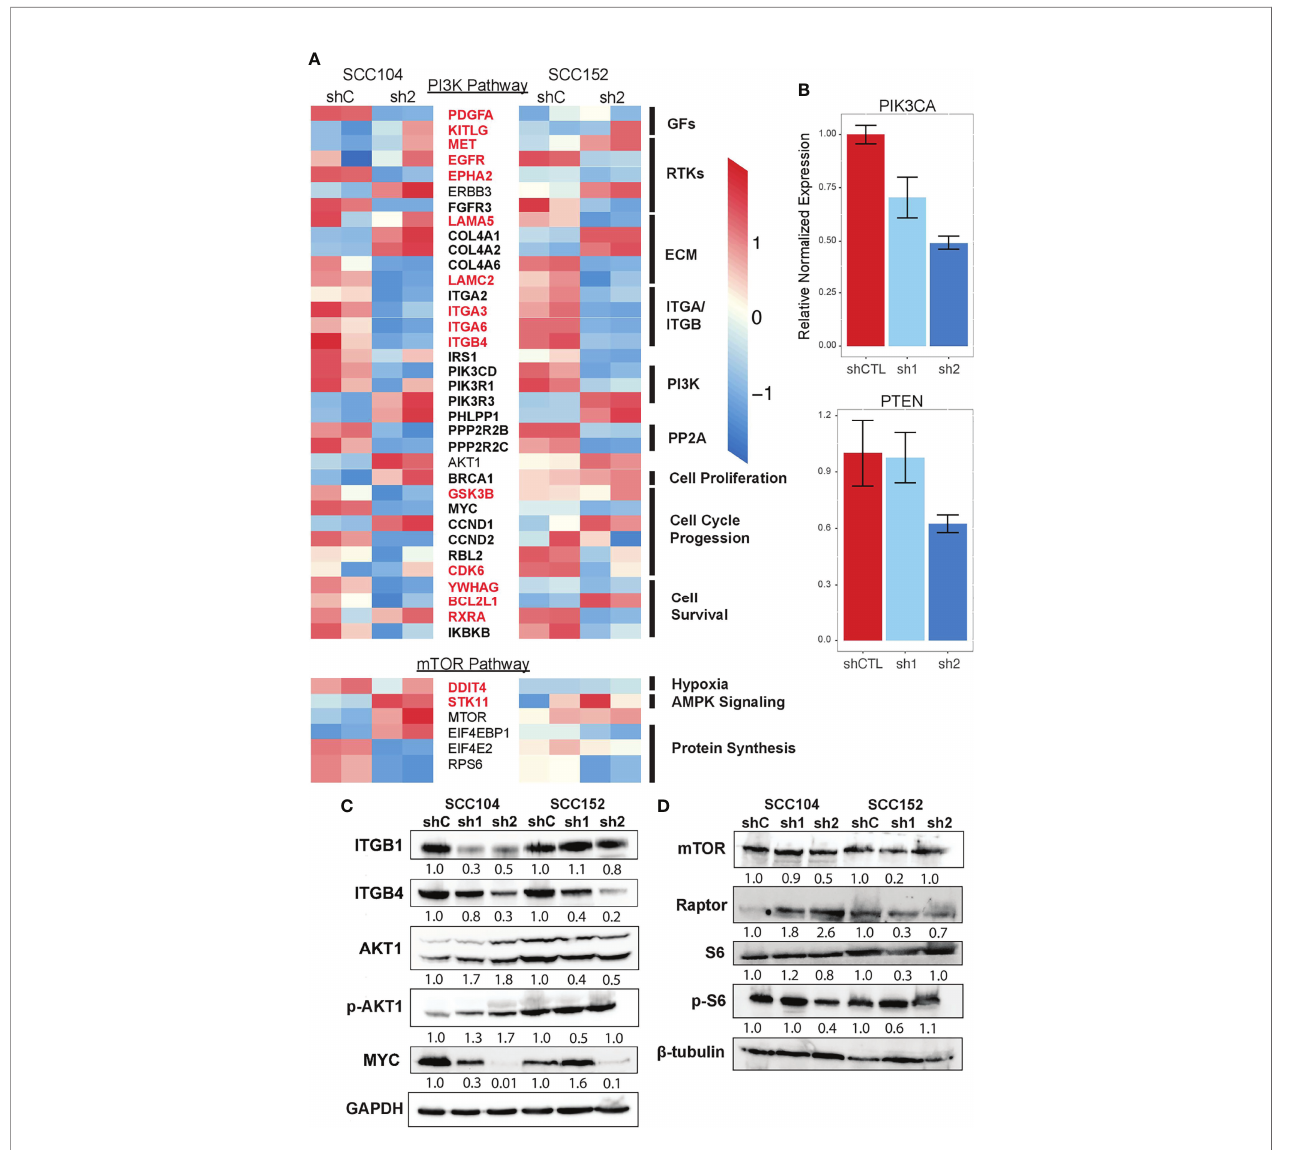
FIGURE 7 | PI3K and mTOR signaling is downregulated upon loss of p63 expression. (A) Heatmap of select DEGs shared between SCC104 and SCC152 cells after p63 knockdown that are associated with activation and regulation of the PI3K signaling pathway. Red-labeled genes are SE marked, and bolded genes are direct p63 targets. (B) qRT-PCR of SCC104 shCTL and p63 shRNA cell lines. Graphs show the relative normalized expression of the catalytic subunit of PI3K as well as the PI3K phosphatase PTEN. (C, D) Western blot results for representative key members of the PI3K pathway (C) and mTOR pathway (D) upon p63 knockdown in SCC104 and SCC152. Densitometric analysis of protein abundance between control (shC) and knockdown (sh1 and sh2) conditions is displayed below each